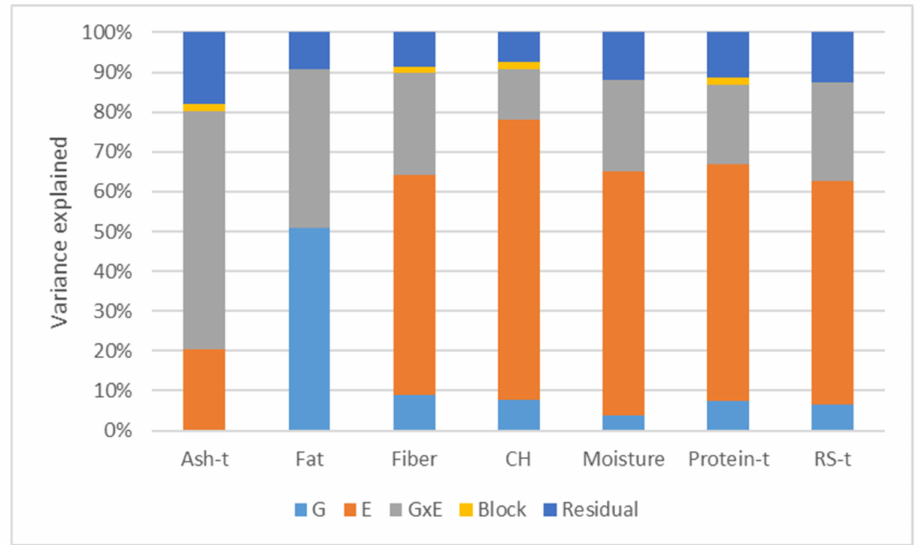
Figure 1. Variance components for the nutritional composition related traits measured in a collection of 106 Portuguese common bean accessions grown in two contrasting environments (Cabrela with a mild climate, and C ó rdoba, a heat stress prone region). The “-t” after the trait’s name indicates that data was transformed following a Box-Cox transformation. Genotype (G), environment (E), genotype by environment interaction (G × E), block, and residual (error), carbohydrates (CH), resistant starch